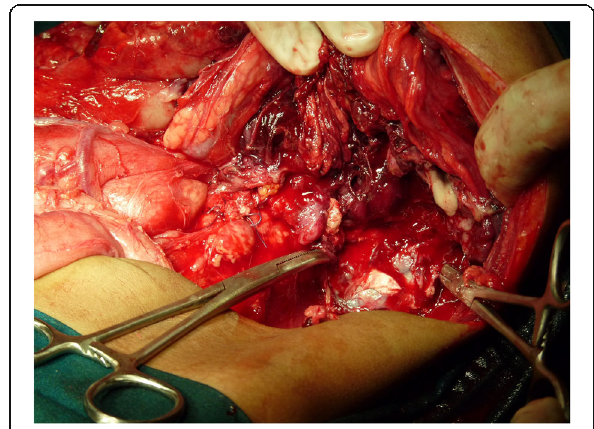
Fig. 4 Intraoperative tumor rupture and spillage during upfront surgery